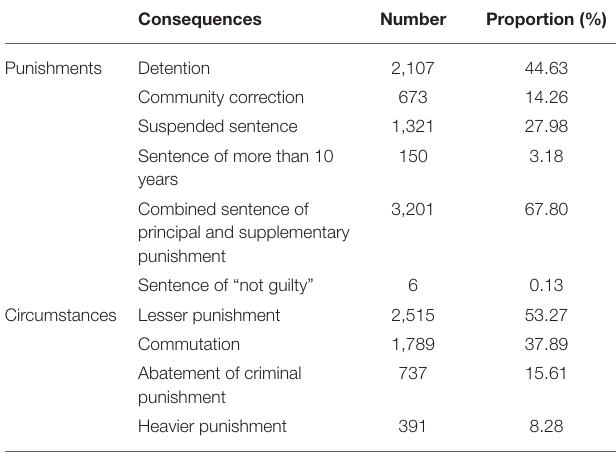
TABLE 2 | The subjective aspects (negligence crime).